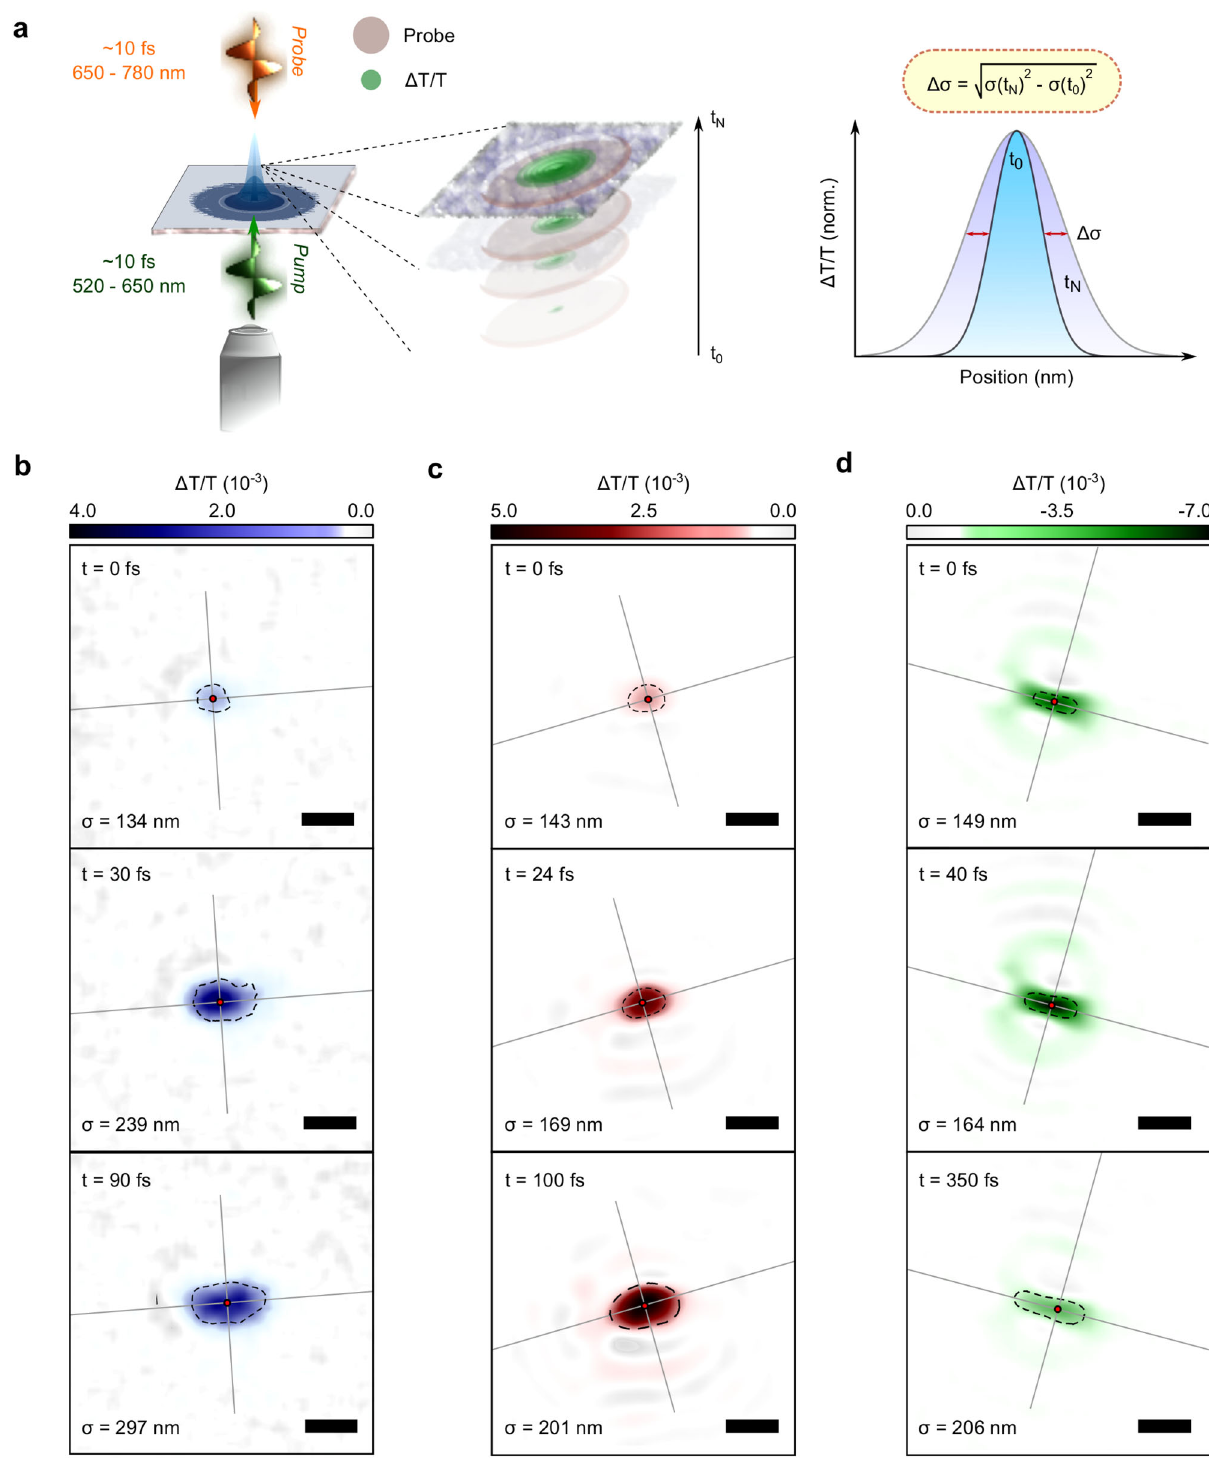
Fig. 3 Femtosecond transient absorption microscopy of organic nanostructures. a Schematic of fs-TAM. A diffraction limited pump pulse (green) is focused onto the sample by a high numerical aperture microscope objective. A probe pulse (yellow) is focussed from the top onto the sample in the wide- fi eld. The transmitted probe is collected by the objective and imaged onto a digital camera (Supplementary Methods). Comparison of the spatial extent of the signal (stack) at different time delays allows us to dynamically track changes in the population with ~10 nm precision (right hand graph). b – d fs-TAM images of PDA, PIC and PDI at selected time delays following photoexcitation. The pump pulse covers the entire (excitonic) absorption of the systems, with probing carried out at 670 nm, 600 nm and 720 nm respectively. In all images in Fig. 1e – g the scale bar is 500 nm and the dotted line indicates the radial Gaussian standard deviation ( σ ; numerical value bottom left) from the excitation centre of mass (red circle). Grey lines indicate the principle transport axes, along and orthogonal to the average wire direction (see Supplementary Note 6 for respective line cuts).